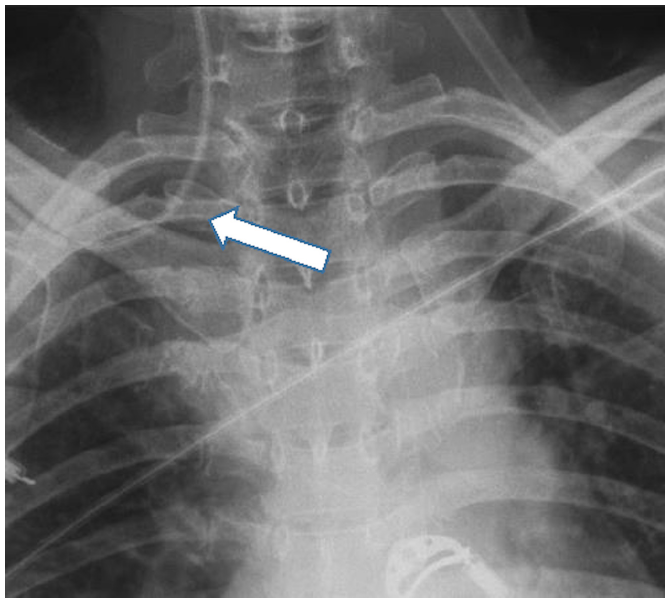
Figure 3. Portable chest radiograph showing a central line catheter placed on the right subclavian vein. The catheter migrated to the right internal jugular vein despite proper procedural technique. Mild resistance was experienced during the wire threading. The patient had history of chronic renal disease. A hemodialysis catheter had been placed in the right subclavian vein for several months and had been removed